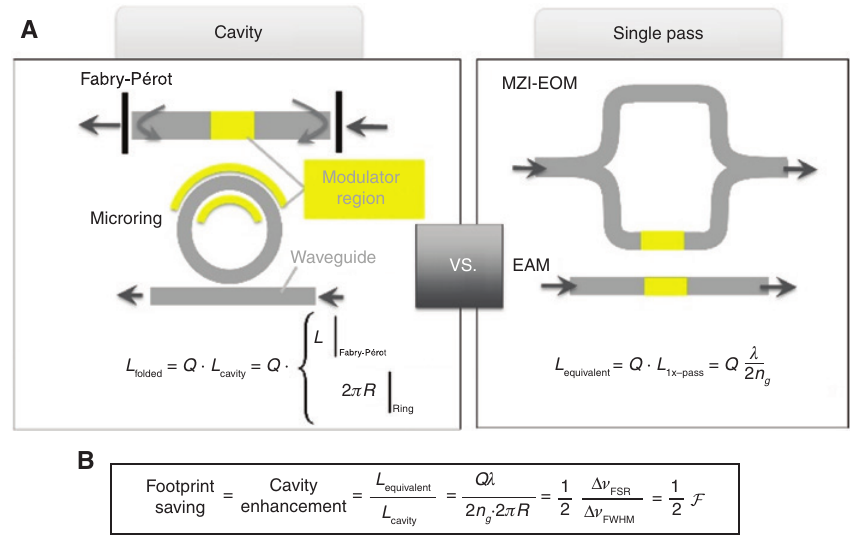
Figure 5: Impact of a cavity on electro-optic modulation. (A) Schematics and effective photon interaction lengths for cavity-based EOMs vs. single-pass devices. (B) Footprint benefit from cavity is proportional to the finesse, ℱ . Definitions: L = physical lengths, Q = quality factor, R = ring radius, n